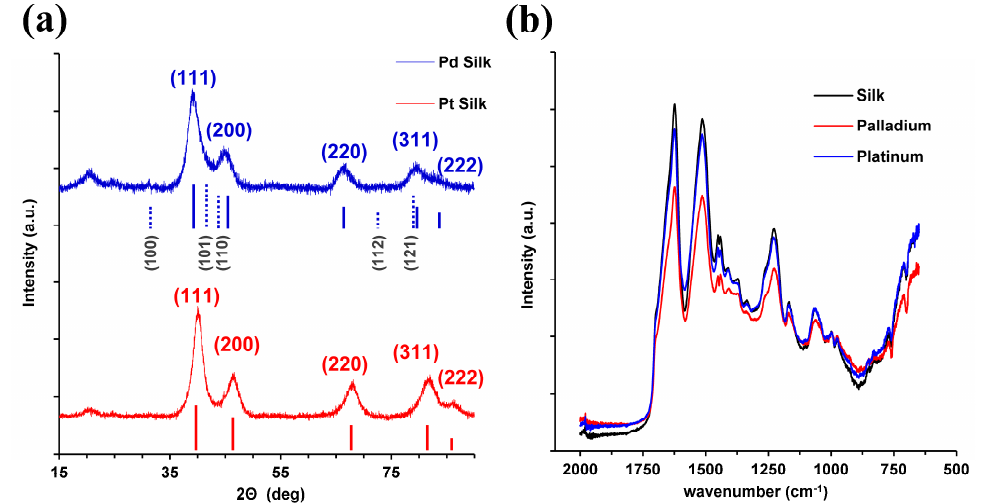
Figure 3. ( a ) X-ray diffraction spectra for silk palladium and platinum composite aerogels. The silk– palladium aerogel peaks are indexed to the Joint Committee on Powder Diffraction Standards (JCPDS) reference 01-087-0637 for palladium (blue lines), 01-073-0004 for palladium hydride (blue dashed lines; Miller indices labeled in gray). The silk–platinum aerogels are indexed to 00-004-0802 (red lines) for platinum. ( b ) Fourier transform infrared (FTIR) spectra for the silk, silk–palladium, and silk–platinum fiber